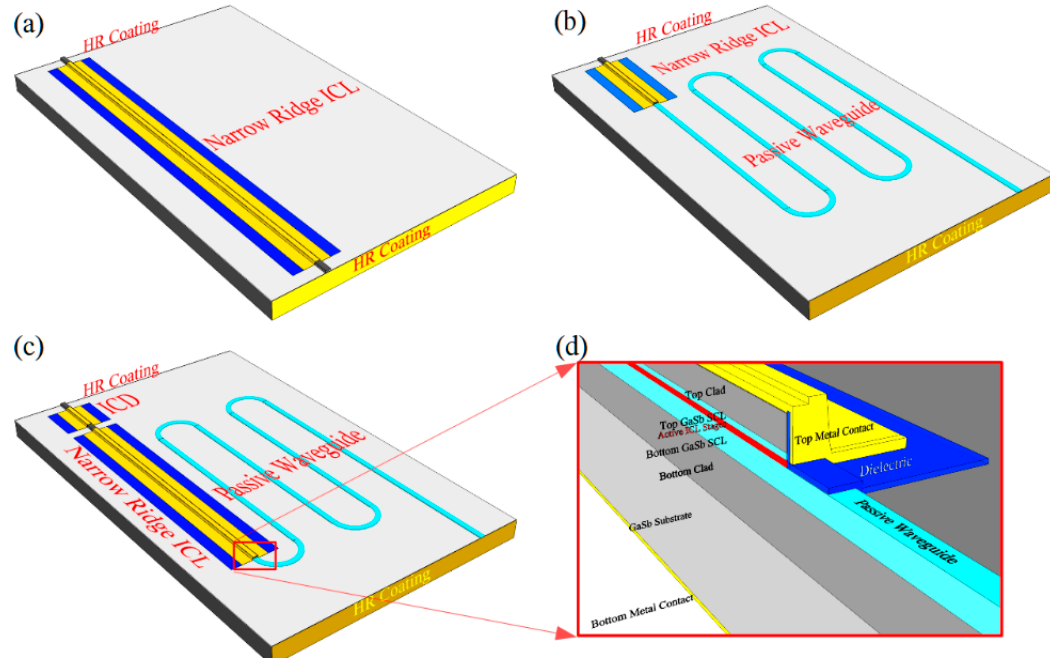
Figure 4. Schematics of laser cavities defined by two HR-coated mirrors: ( a ) the laser does not interact with any optical element outside its own cavity; ( b ) a passive waveguide inside the laser cavity evanescently couples to ambient; ( c ) both a passive sensing waveguide and an interband cascade detector (ICD) are incorporated inside the cavity; ( d ) detail of the interface between the active and passive waveguides.